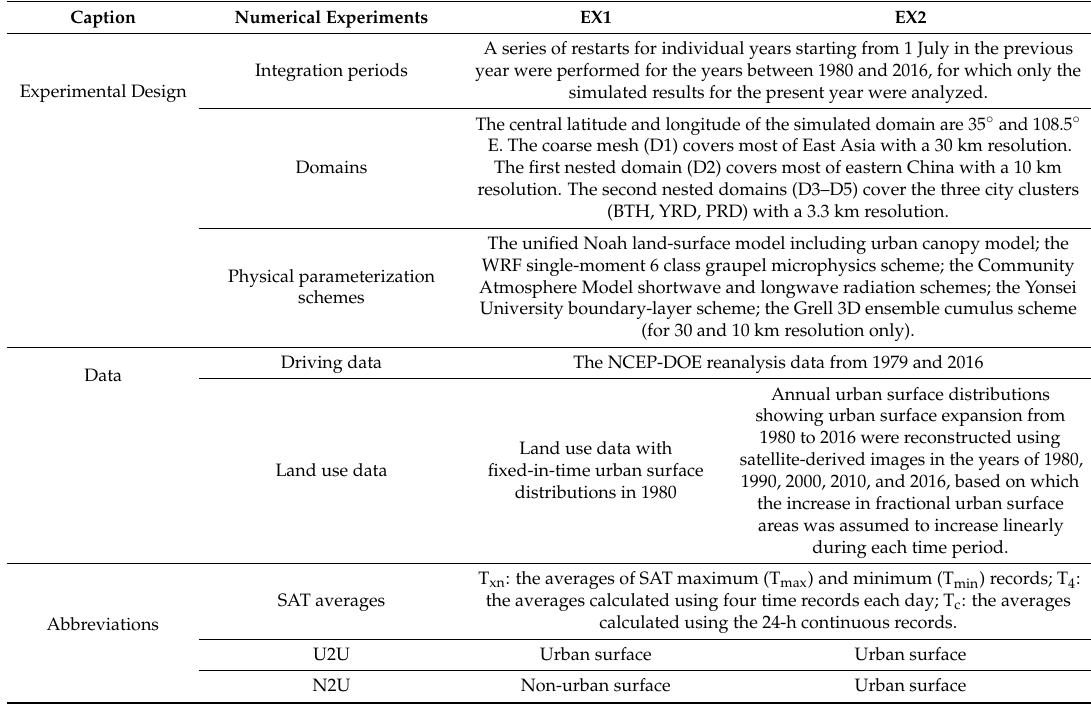
Table 1. Summary of experimental design, data, and abbreviations used in the integrations.